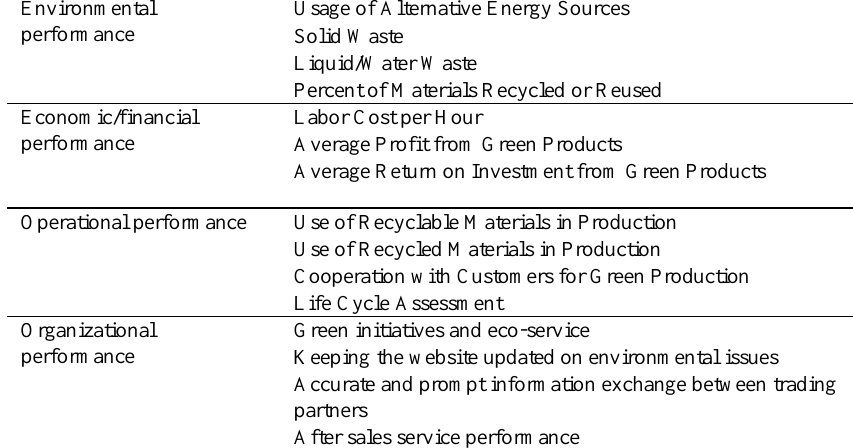
Table 2. Indicators of circular economy